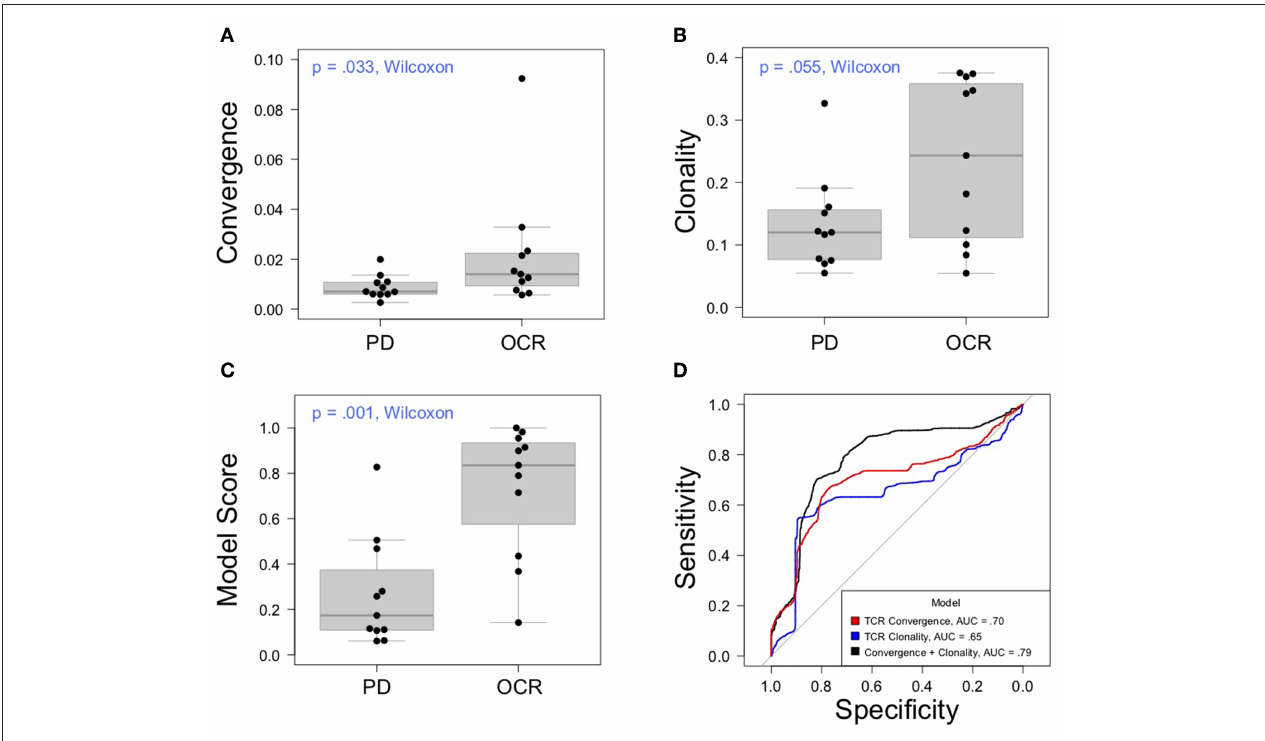
FIGURE 3 | Association between clinical outcomes and TCR convergence. (A) TCR convergence and (B) clonality for responders ( N = 11) and non-responders ( N = 11) to CTLA-4 blockade for cancer. TCR clonality is calculated as 1—the normalized Shannon entropy of clone frequencies. Convergent TCR frequency was calculated as described in methods. All cancer types were included in the analysis. (C) Response probability scores from a logistic regression classifier trained using TCR clonality and convergence as features to predict response to immunotherapy. Score indicates likelihood that a sample is a responder. (D) Receiver operator characteristic curves derived from leave-group-out cross validation analysis of models using clonality, convergence, or the combination of clonality and convergence to predict immunotherapy response. ROC curves represent the average model performance following 2,000 random train-test splits, where 75% of the dataset was used to train the model followed by testing on the remaining 25%. The combination of TCR clonality and convergence shows better performance (AUC = 0.89) than models using TCR convergence and clonality alone (AUC of 0.70 and 0.65,